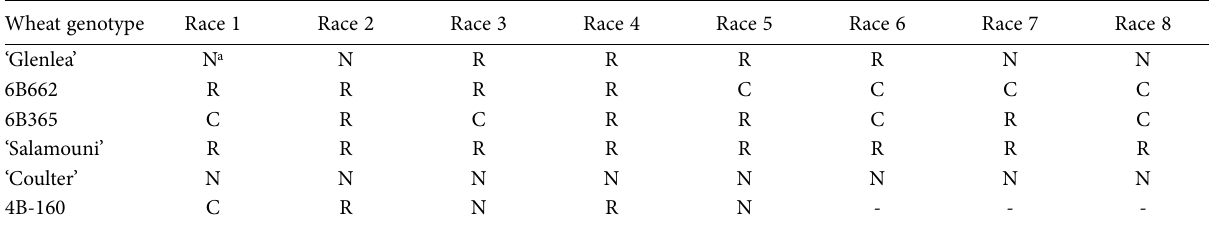
Table 2. Reaction types a of the eight races of Pyrenophora tritici-repentis on six international wheat differential genotypes. Wheat